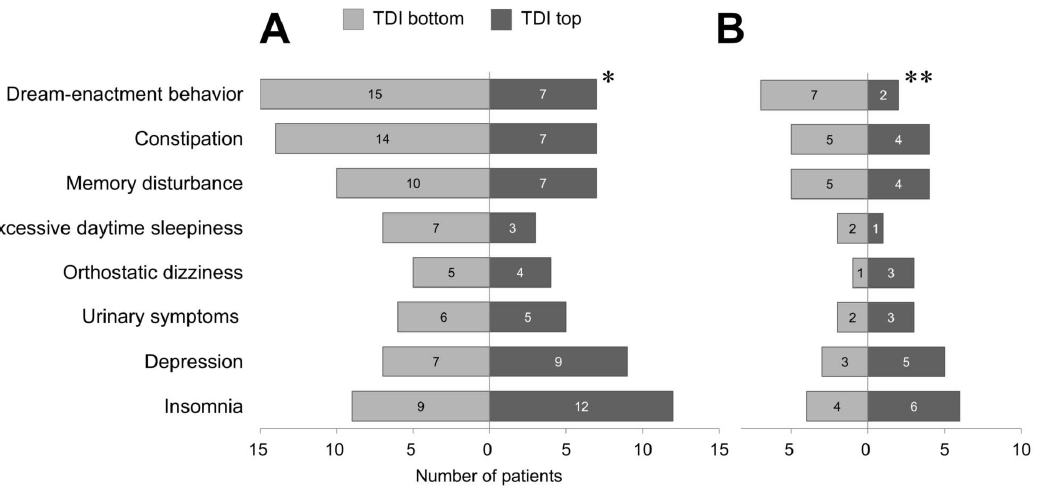
Figure 2. Group differences in nonmotor manifestations based on the KVSS II TDI score (* P =0.029; ** P =0.046, chi-square test or Fisher’s exact test, as appropriate). ( A ) all PD patients. ( B ) de novo PD